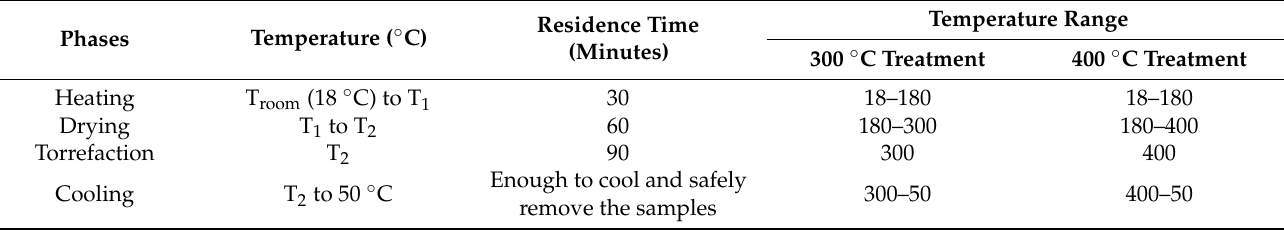
Table 1. Correspondence of the four programmable levels with the different phases, depending on the temperature and residence time.